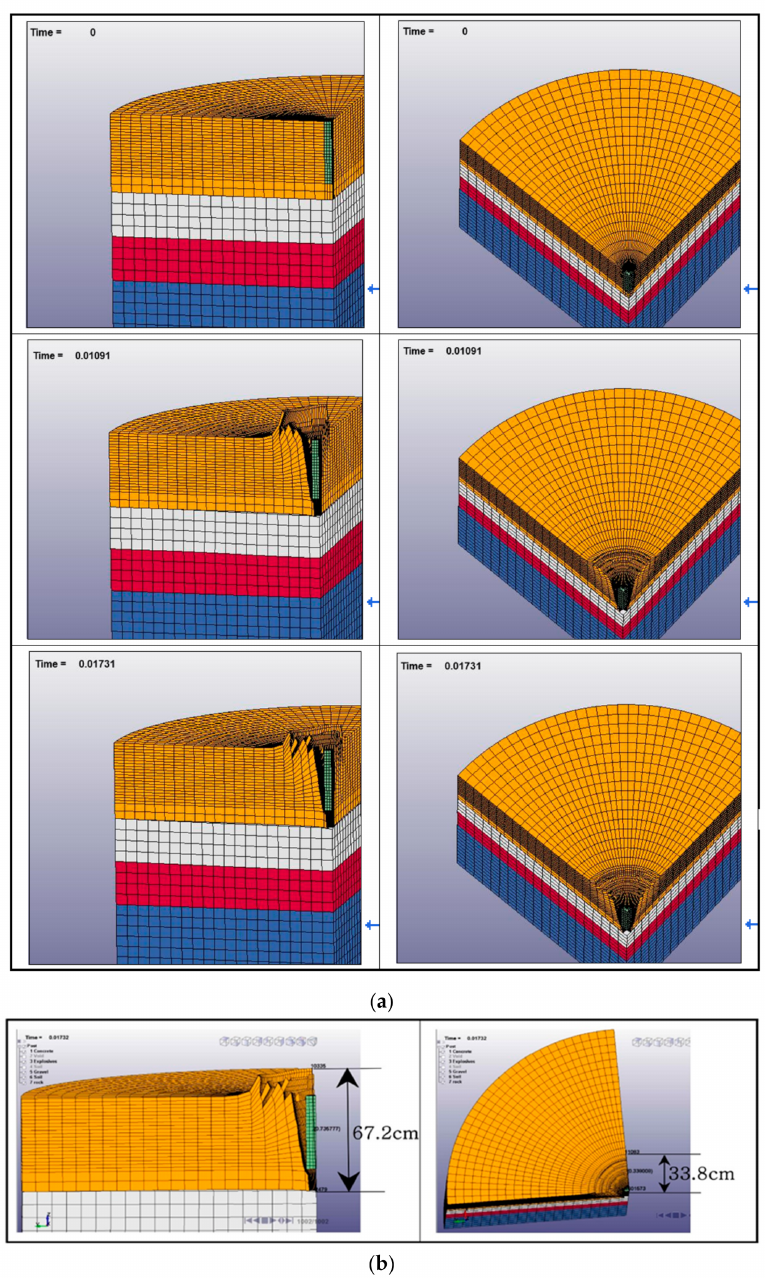
Figure 4. Result of the pavement damage: ( a ) Fracture shape by time; ( b ) Crater width and